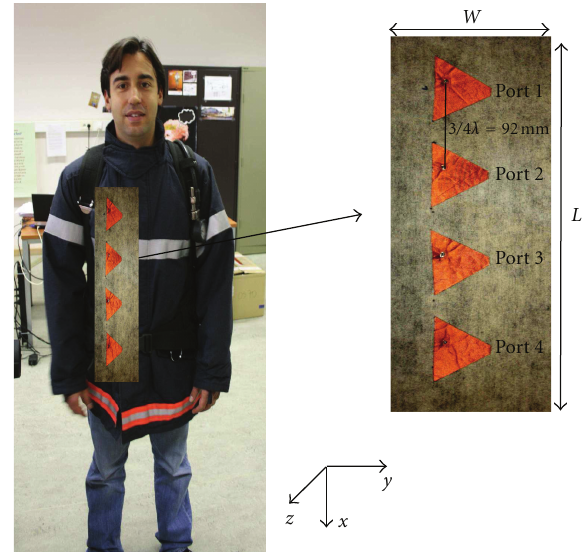
Figure 1: Top view of the textile antenna array and its position on the human body. (Note that in this figure, for illustrative purposes, the array is shown exposed on top of the garment. In reality, however, it is integrated into the